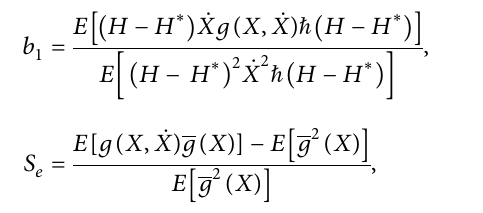
Figure 10: The mean up-crossing rate υ + excursion a c under α � 1 . 5 ( k and circles: MCS